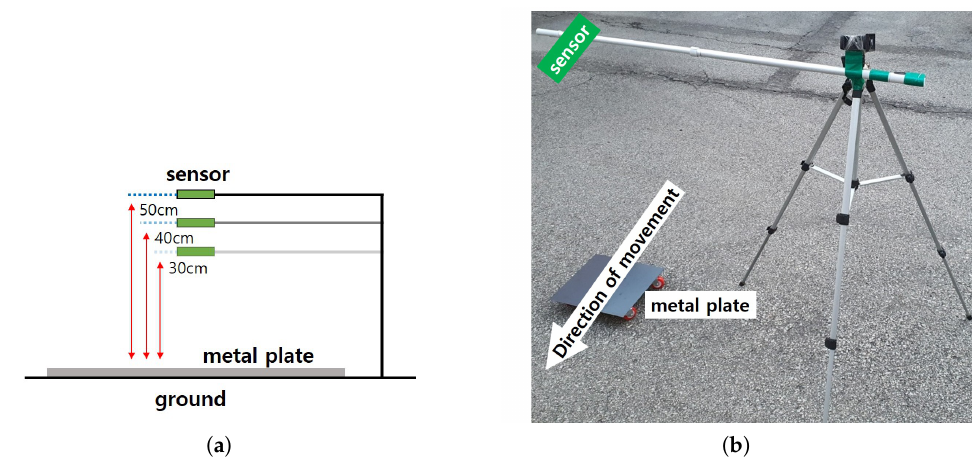
Figure 6. Experimental environment. ( a ) is experimental design and ( b ) is external experimental environment.